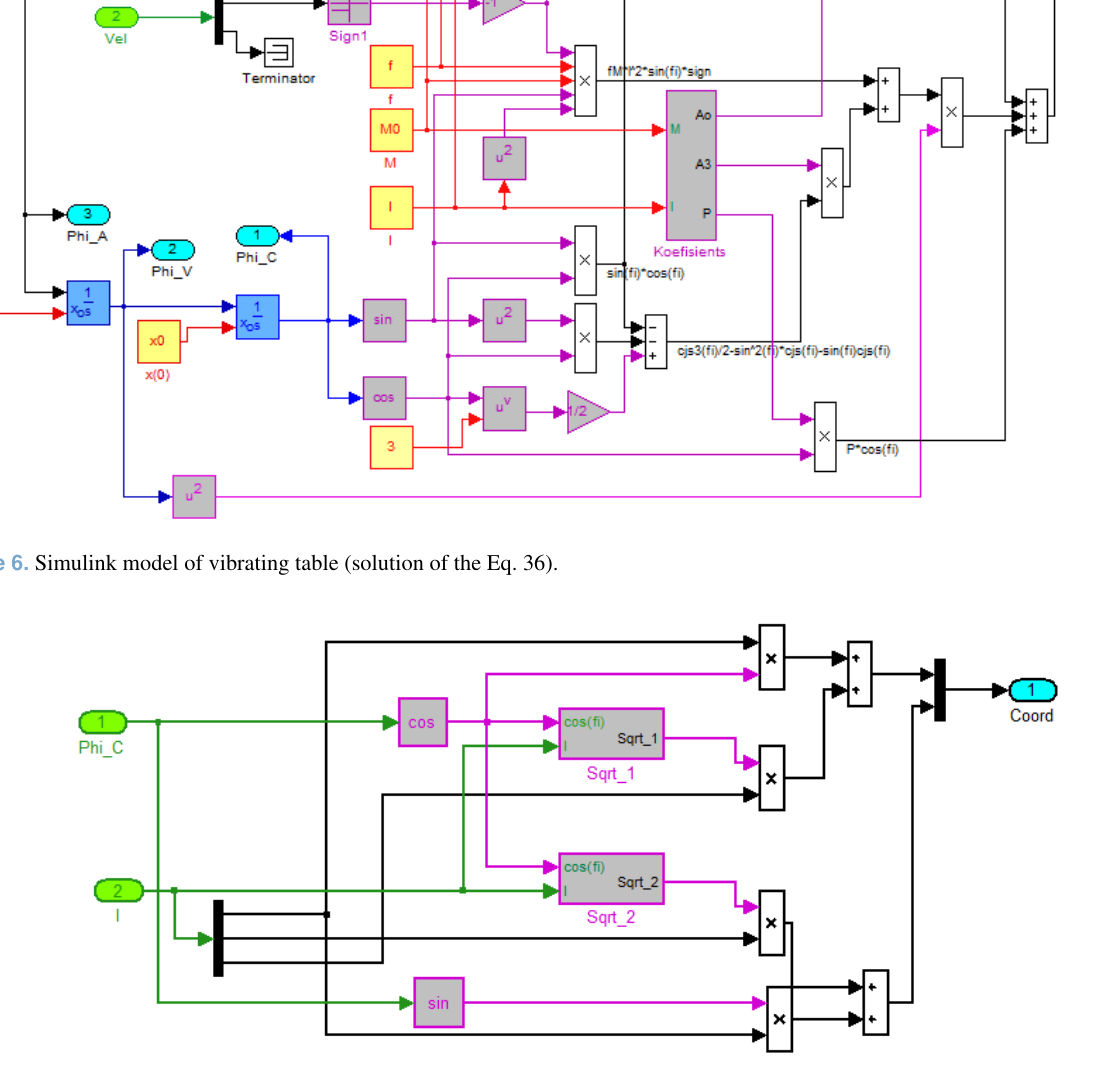
Figure 7. Determination of the coordinates of point C (calculation using Eq.